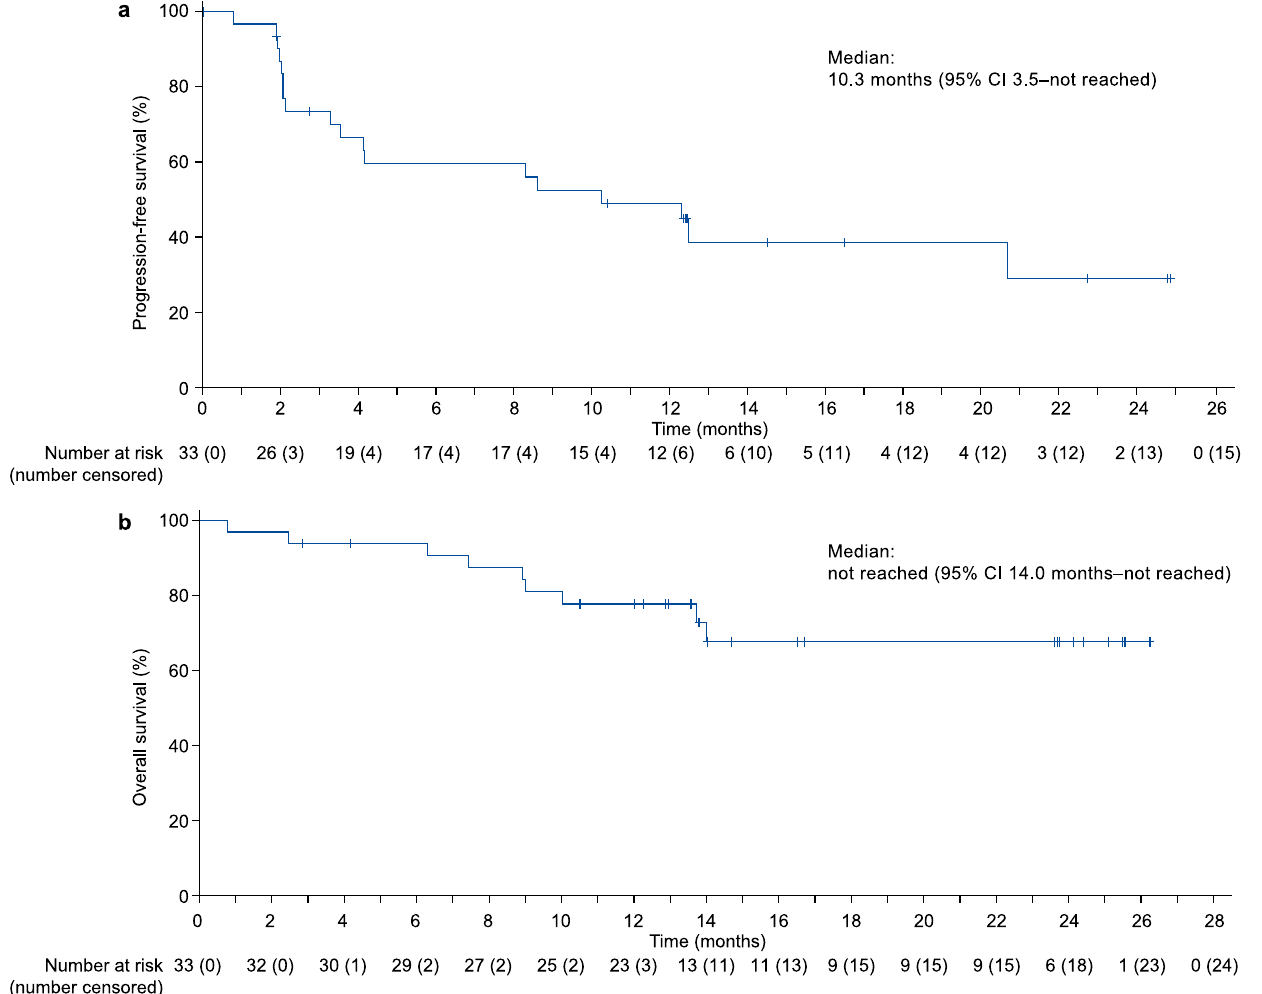
Fig. 3 | Kaplan – Meier curves of progression-free survival and overall survival. a Progression-free survival. b Overall survival. Data are for the full analysis popula- tion ( N